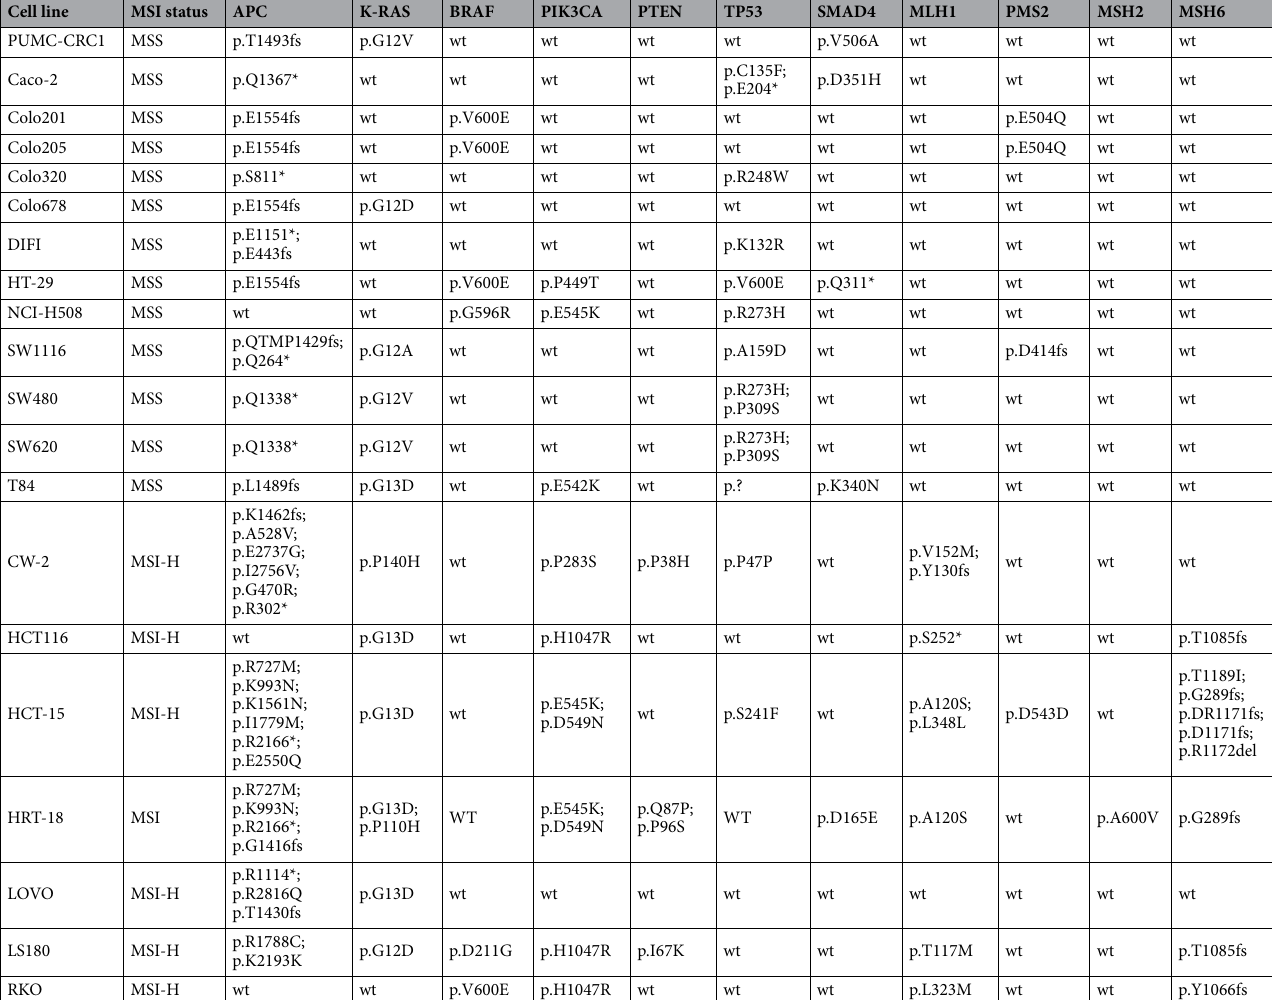
Table 3. Comparison of MSI status and mutation status of cancer critical genes in PUMC-CRC1 and 19 commonly-used CRC cell lines. Gene mutations of 19 commonly-used CRC cell lines were obtained at the Cancer Cell Lines Encyclopedia (CCLE, https:// porta ls. broad insti tute. org/ ccle), the Catalogue of Somatic Mutations in Cancer (COSMIC, https:// cancer. sanger. ac. uk/ cell_ lines) and the Cellosaurus (https:// web.